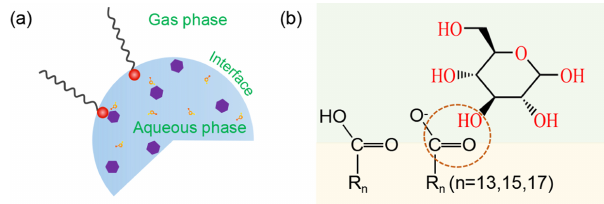
Figure 8. (a) Proposed model of fatty acid–saccharide interaction at the air/water interface. (b) Description of possible mechanisms of fatty acid–saccharide interaction at the air/water